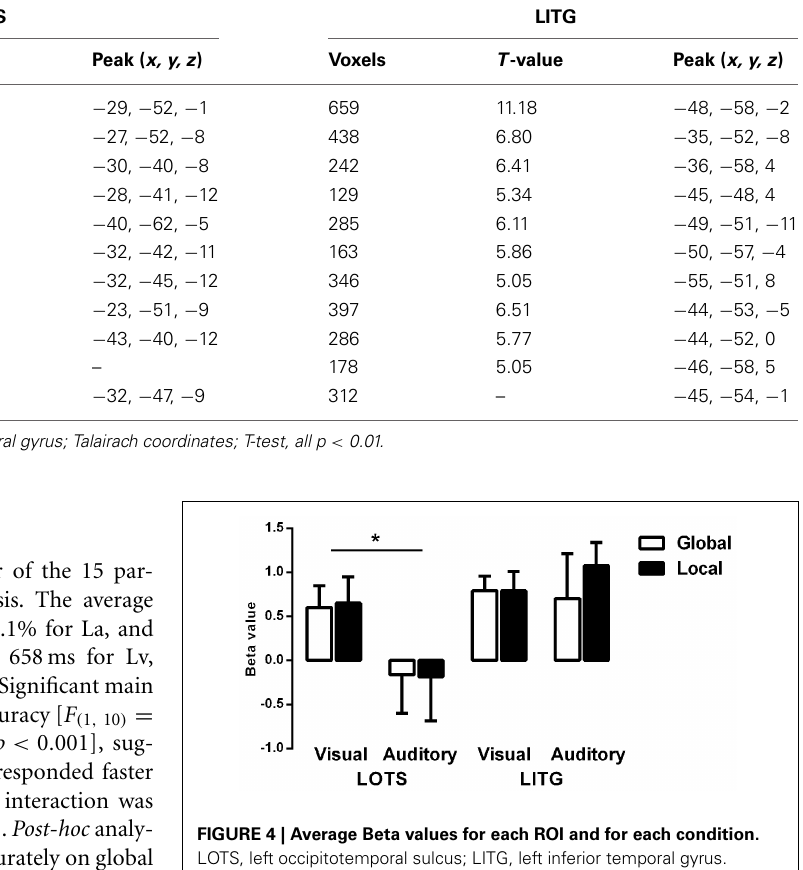
Table 3 | Two regions of interest (ROIs) showing significant activation for Chinese characters compared to faces. Subject no.